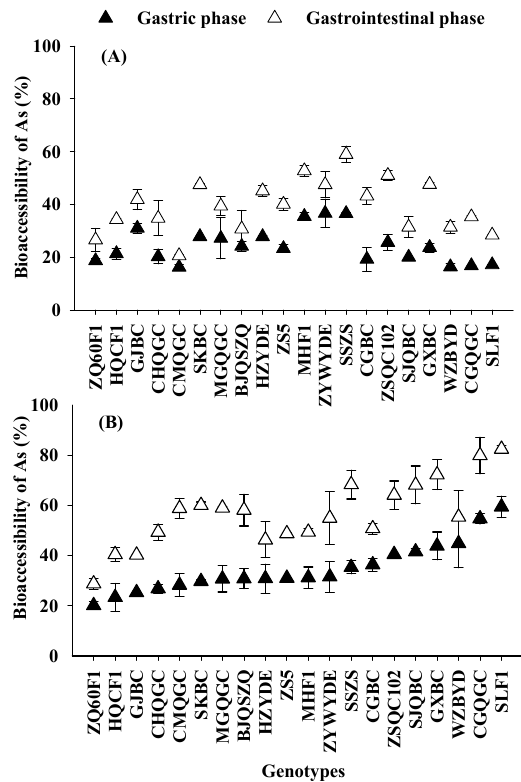
Figure 5. Arsenic bioaccessibility (%) during gastric phase and gastrointestinal phase of pakchoi among 20 genotypes grown on at low-level co-contaminated soil ( A ) and high-level co-contaminated soil ( B ). Error bars depict standard errors of the means ( n = 3).